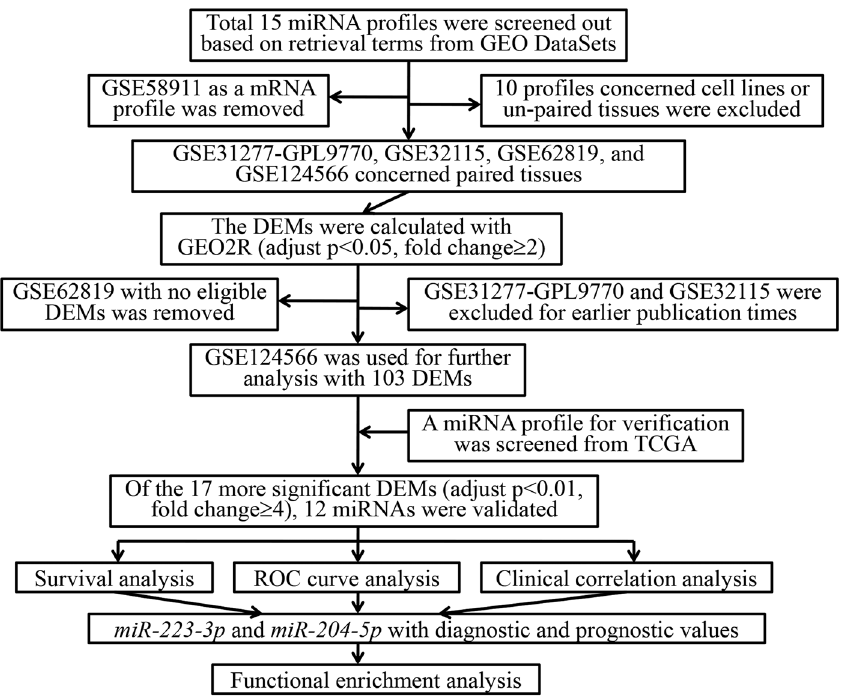
Figure 1: Flowchart for analyses. GEO, gene expression omnibus , DEMs, di ff erential expressed miRNAs, TCGA, the cancer genome atlas, ROC, receiver operating characteristic.